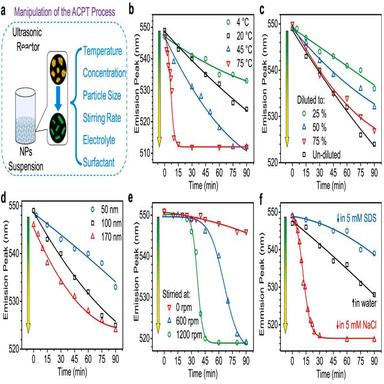
Influential factors of ACPT process of ETTDA NPs suspension (a): temperature (b), dilution by water (c), NPs size (d), magnetic stirring speed (e), electrolyte (NaCl) and surfactant (SDS) (f) in water. The arrows indicate the blue shift of the emission peak caused by the ACPT. (For interpretation of the references to color in this figure legend, the reader is referred to the web version of this article.)